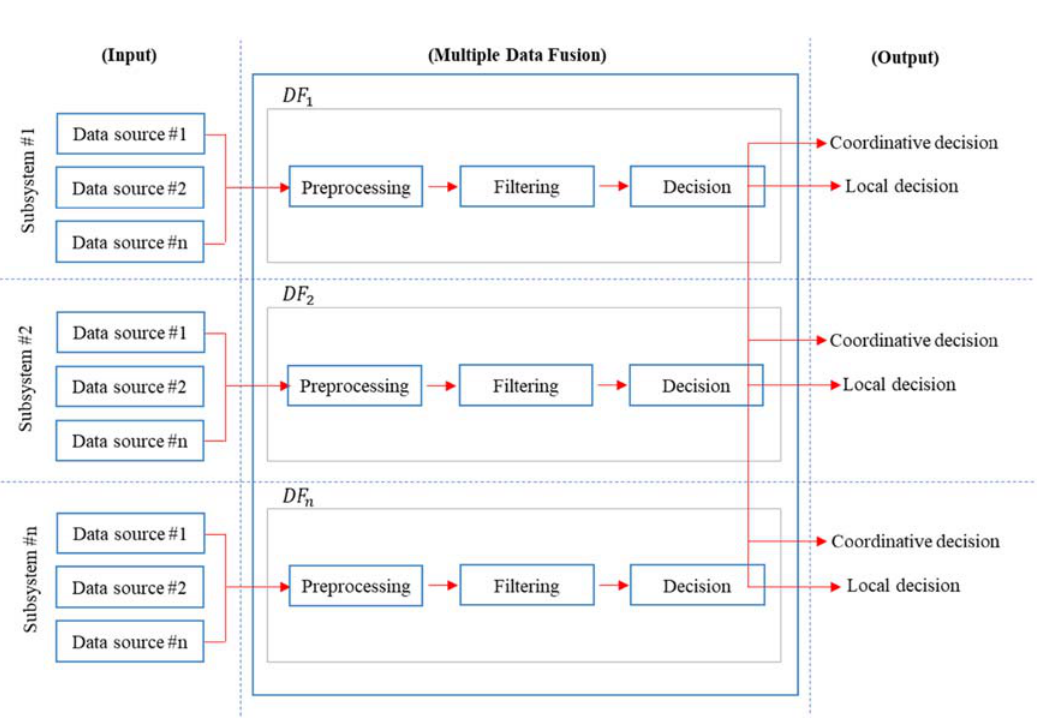
Figure 2: The MCDFM